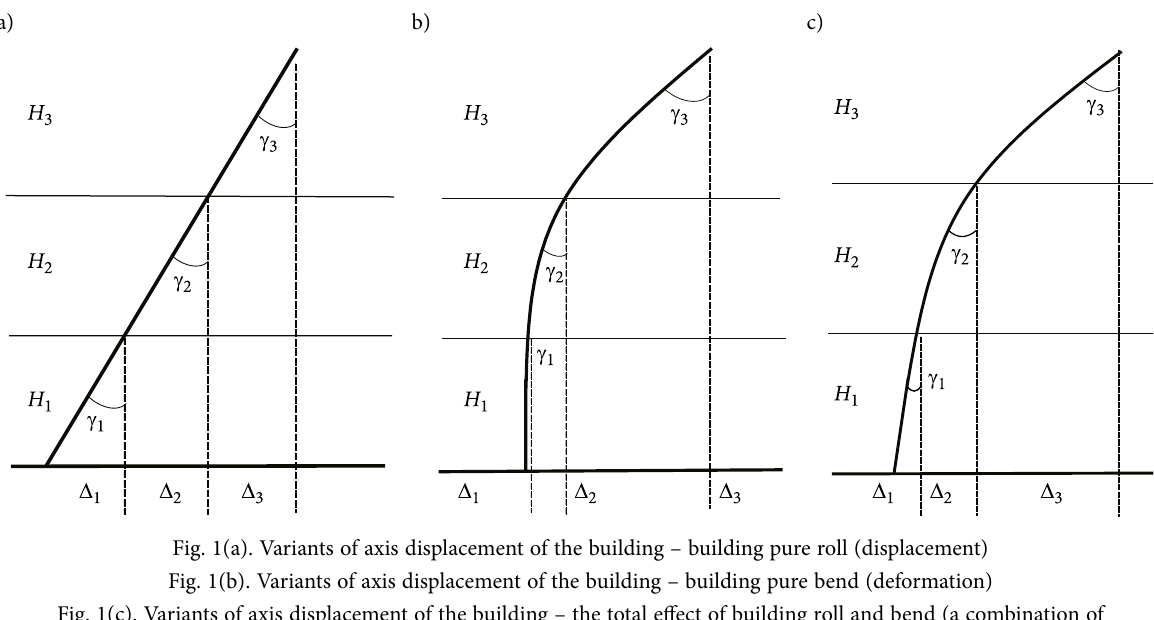
Fig. 1(a). Variants of axis displacement of the building – building pure roll (displacement) Fig. 1(b). Variants of axis displacement of the building – building pure bend (deformation) Fig. 1(c). Variants of axis displacement of the building – the total effect of building roll and bend (a combination of displacement